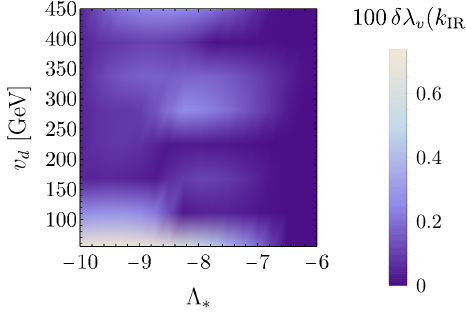
Figure 8 . Difference δλ v ( k IR ) = λ ( without ) v ( k IR ) − λ ( with ) v ( k IR ) in the IR visible self-coupling between a setup that considers portal terms in the flow of λ and a setup that ignores such terms. The UV v initial conditions for both cases are the same, and obtained in a fixed-Yukawa